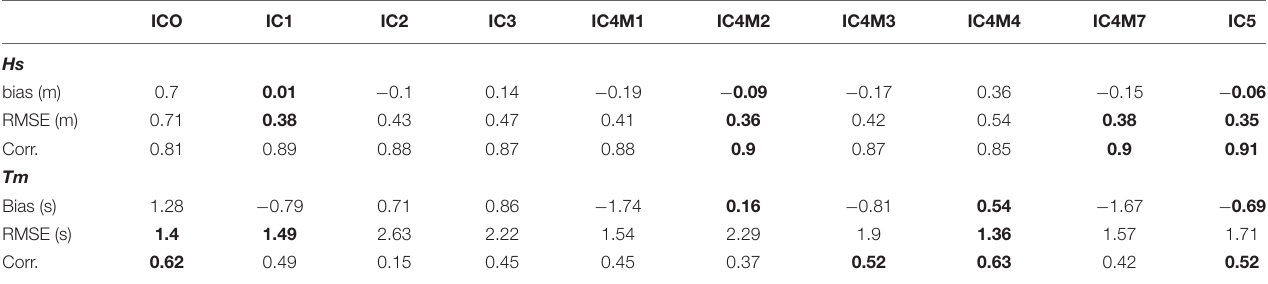
FIGURE 6 | Same as Figure 4 but for high ice-covered condition (ice concentration > 50%): (A) H s and (B) T m . TABLE 2 | Same as Table 1 but for the high ice-covered conditions (ice concentration >